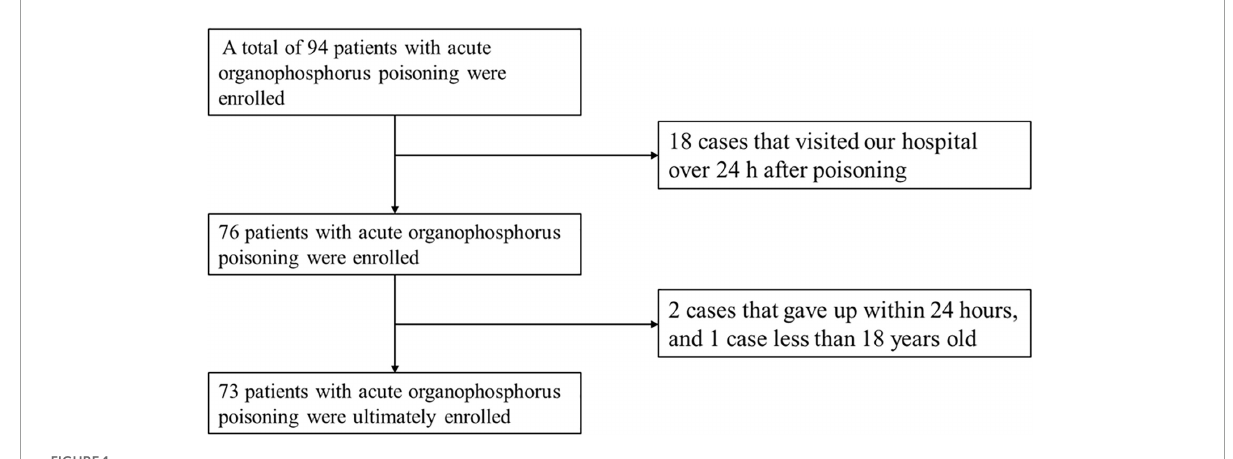
FIGURE1 Eligibility criteria for study cohort participants.